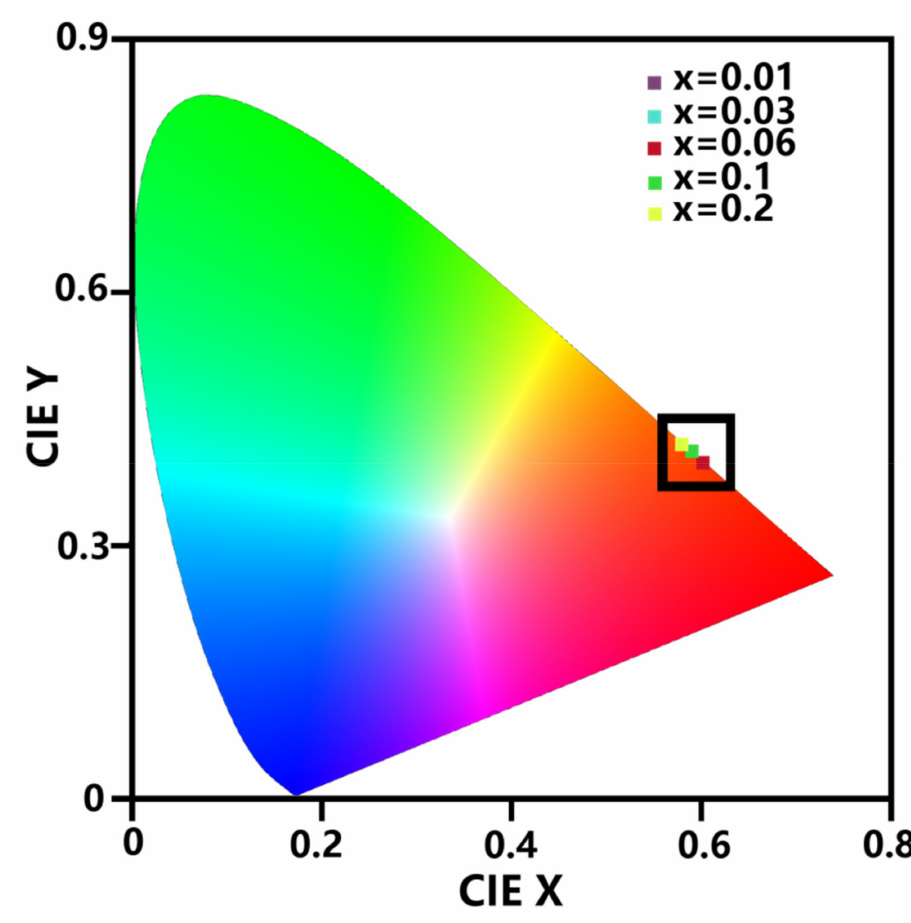
Figure 9. CIE chromaticity of Al 2 O 3 -(3-x)SrO: xSm 3+